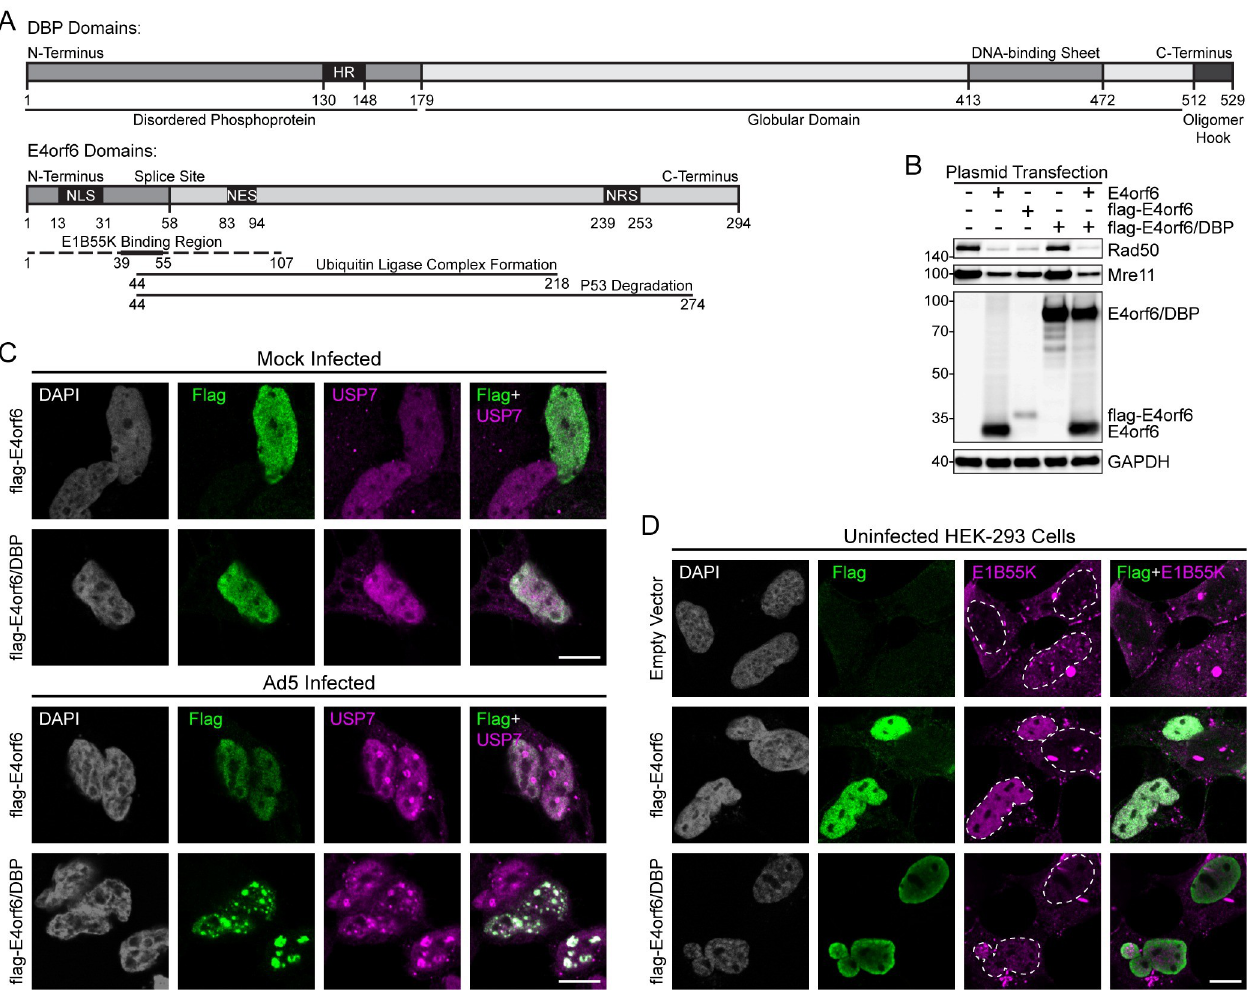
Fig 5. The E4orf6 protein generates an E3 ubiquitin ligase complex with E1B55K but this is not observed for the E4orf6/DBP fusion. (A) Domain map of DBP and E4orf6 open reading frames. HR: host range, NLS: nuclear localization sequence, NES: nuclear export sequence, NRS: nuclear retention sequence. (B) HEK293 cells were transfected with E4orf6, flag-E4orf6, or flag-E4orf6/DBP and subjected to immunoblot analysis. E4orf6, but not E4orf6/DBP, induces degradation of Mre11 and Rad50 through a complex with E1B55K (C) HEK293 cells were transfected with flag-E4orf6 or flag-E4orf6/DBP and